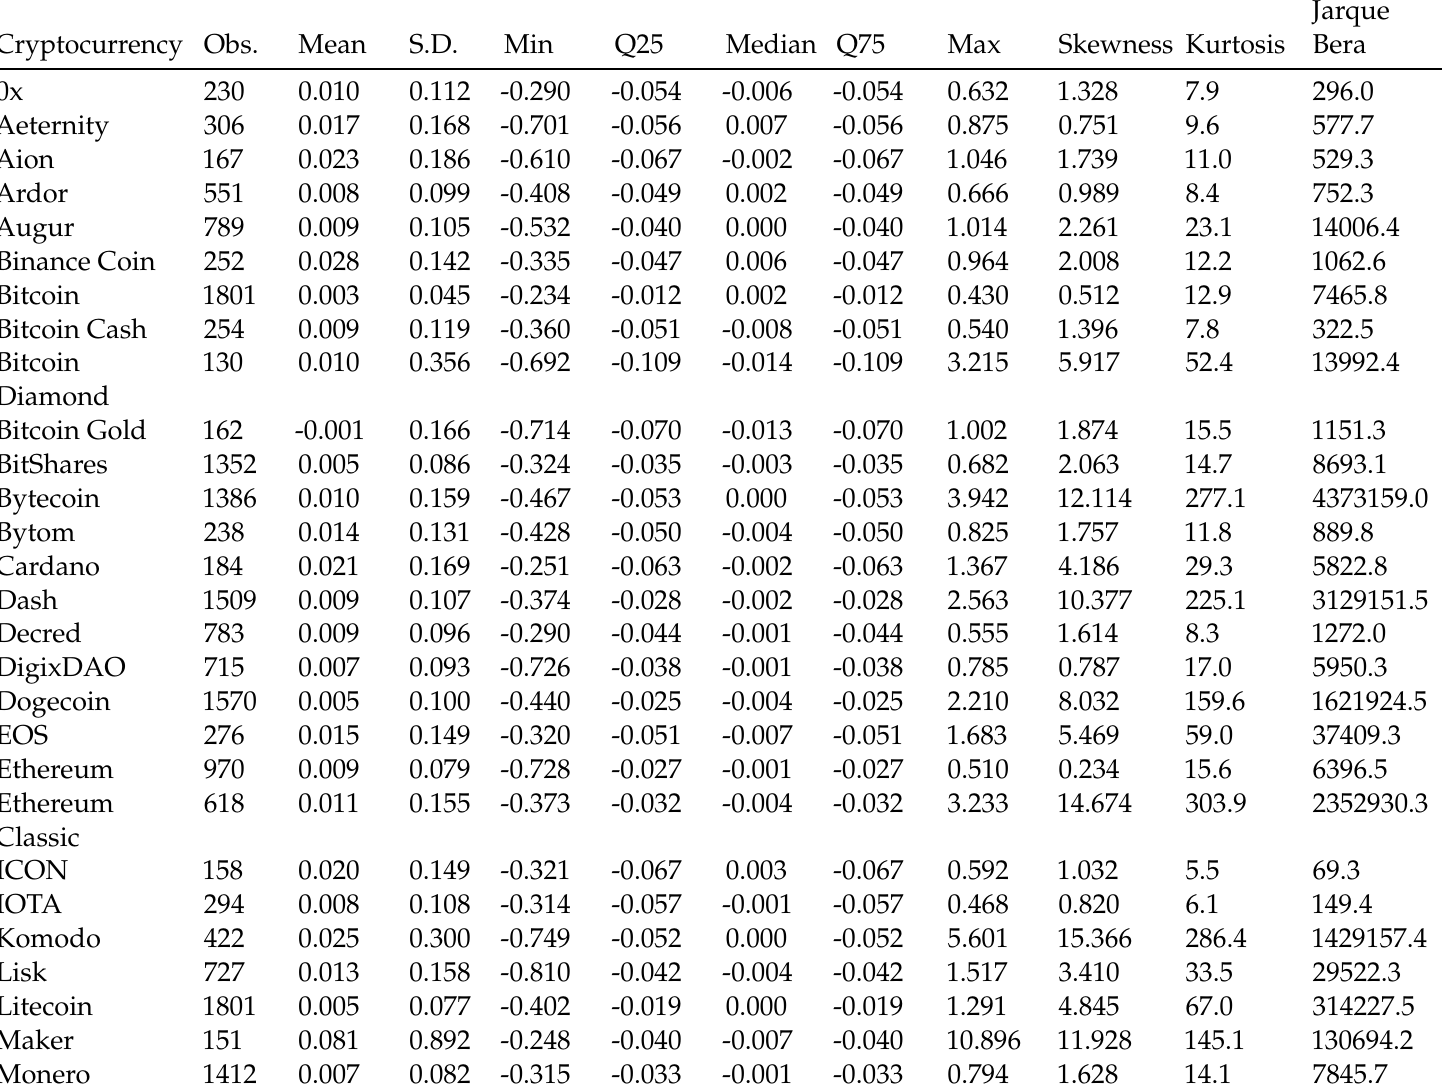
Table 1: Summary statistics of returns for the top 50 cryptocurrencies